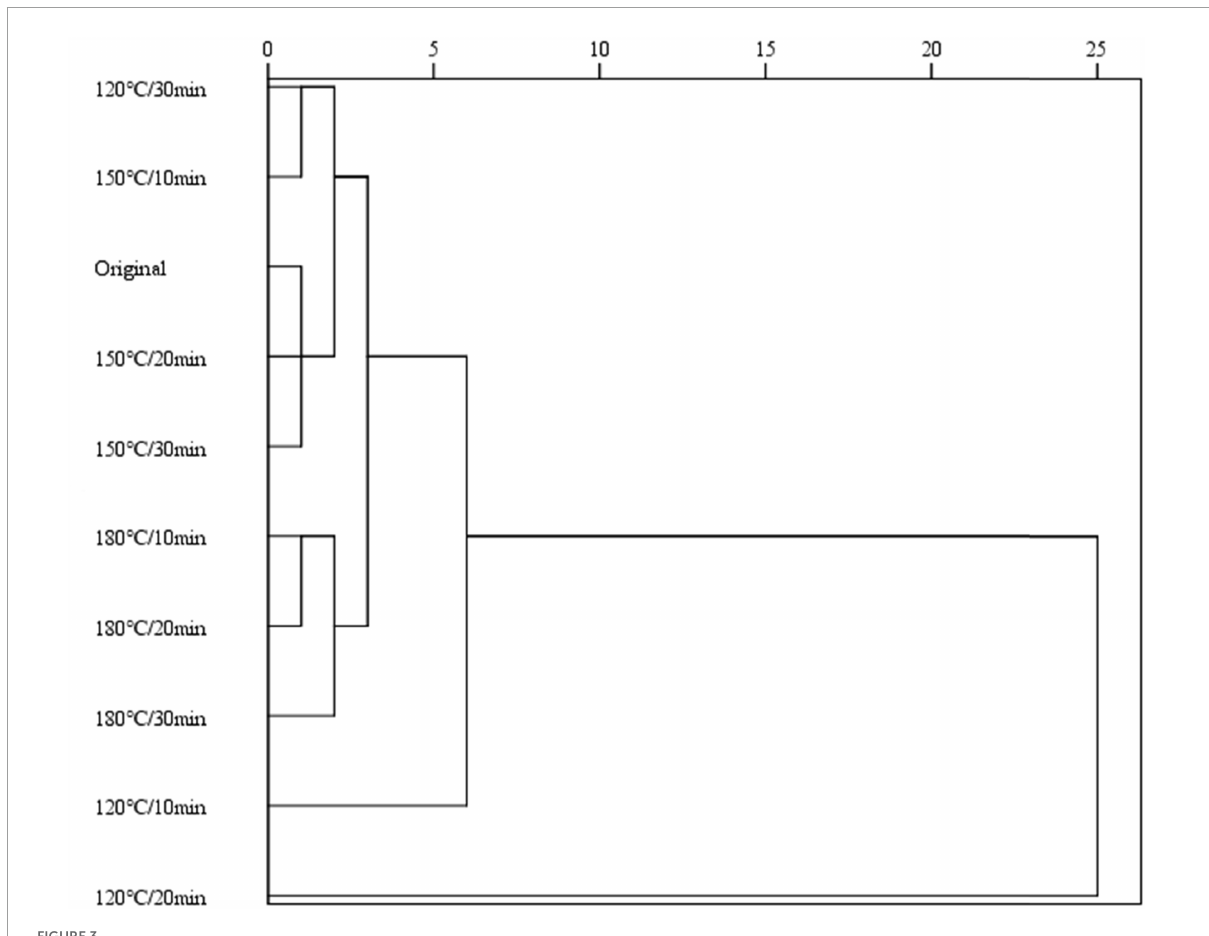
FIGURE3 Hierarchical cluster analysis of walnut